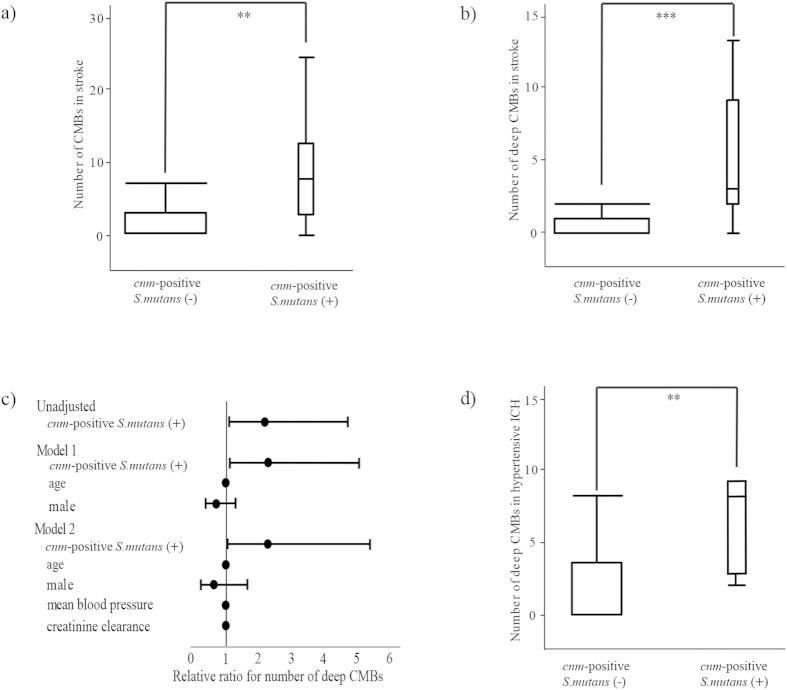
Association of cnm-positive S. mutans with CMBs.(a,b) In total subjects with acute cerebrovascular disease (n = 99), the numbers of CMBs (a) and deep CMBs (b) were significantly greater in subjects with cnm-positive S. mutans than those without. (c) cnm-positive S. mutans was associated with deep CMBs before and after adjusted for established risk factors for ICH, such as age, sex, mean blood pressure and creatinine clearance. (d) Among subjects with hypertensive ICH (n = 23), the number of deep CMBs was significantly higher in subjects with cnm-positive S. mutans than those without. Error bars show 95% confidence interval. S. mutans indicates Streptococcus mutans; CMBs, cerebral microbleeds; ICH, intracerebral hemorrhage. *p < 0.01, **p < 0.001.